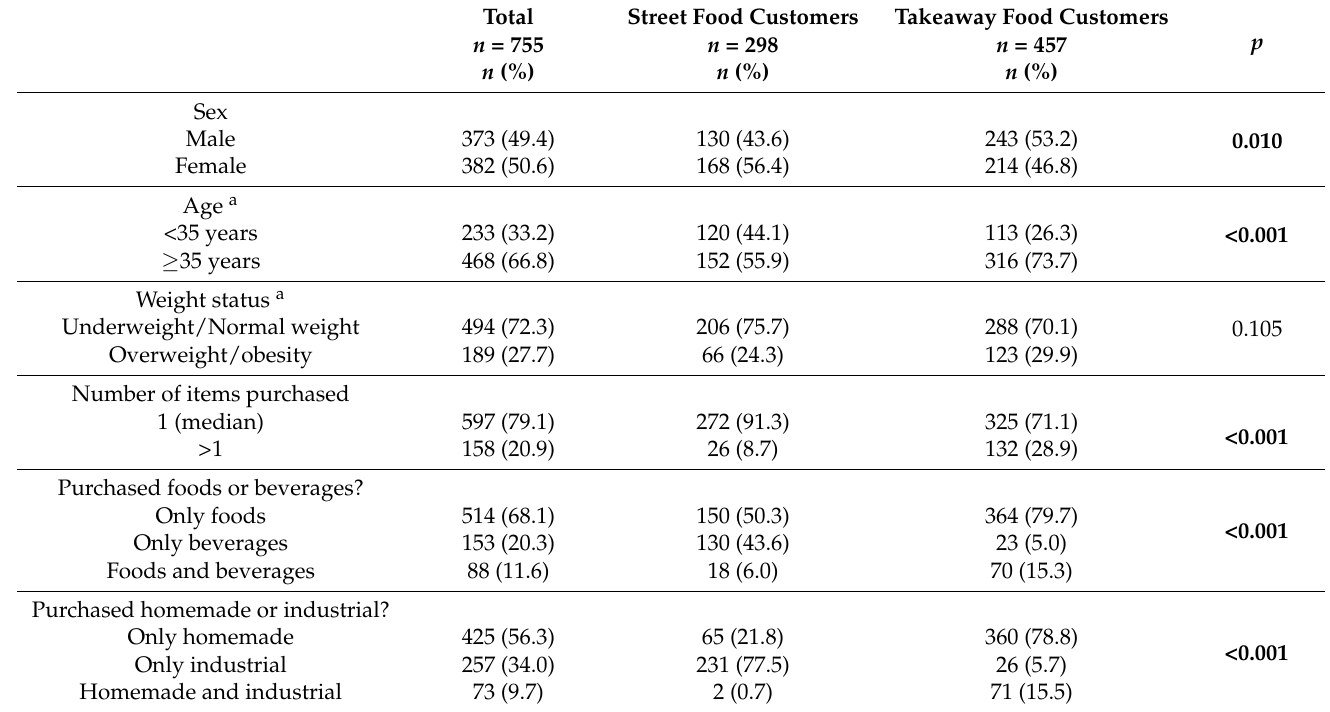
Table 1. Customer’s demographic and anthropometric characteristics, and items purchased, estimated by direct observation of street food and takeaway food vending sites in Sarajevo and Banja Luka, Bosnia and Herzegovina. Total Street Food